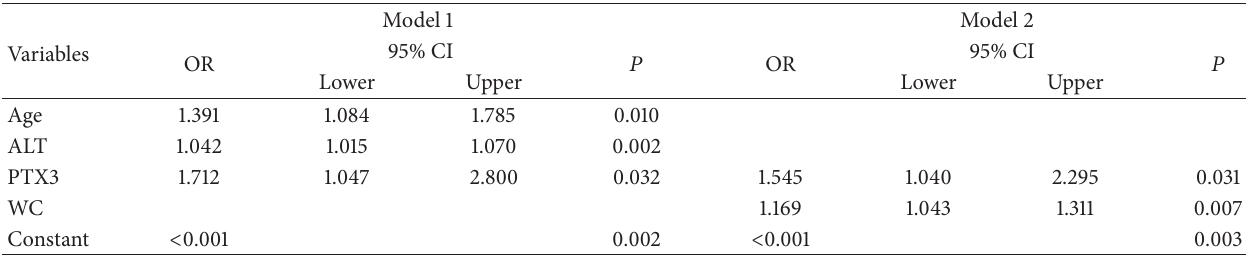
Table 3: Logistic regression analysis of predictors associated with fibrosis in